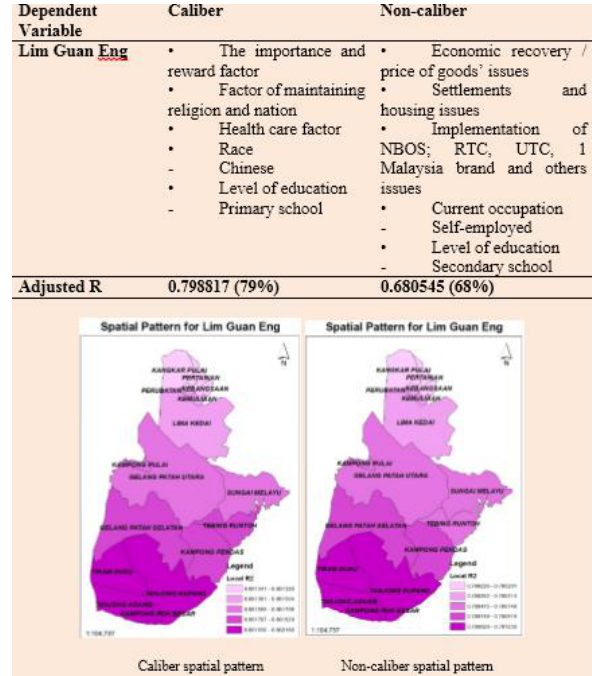
Figure 23. Explanatory variable for Lim Guan